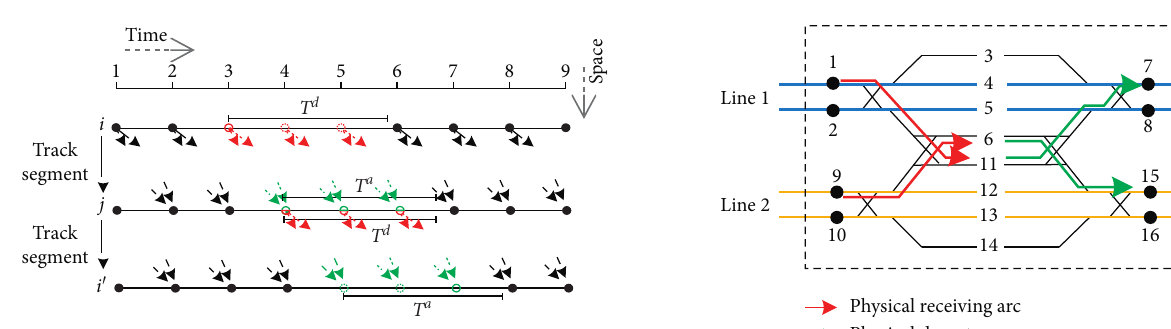
Figure 4: Illustration of the arrival and departure constraints on a track segment. Figure 5: Illustration of receiving-receiving and departure-de- parture conflicts in a hub